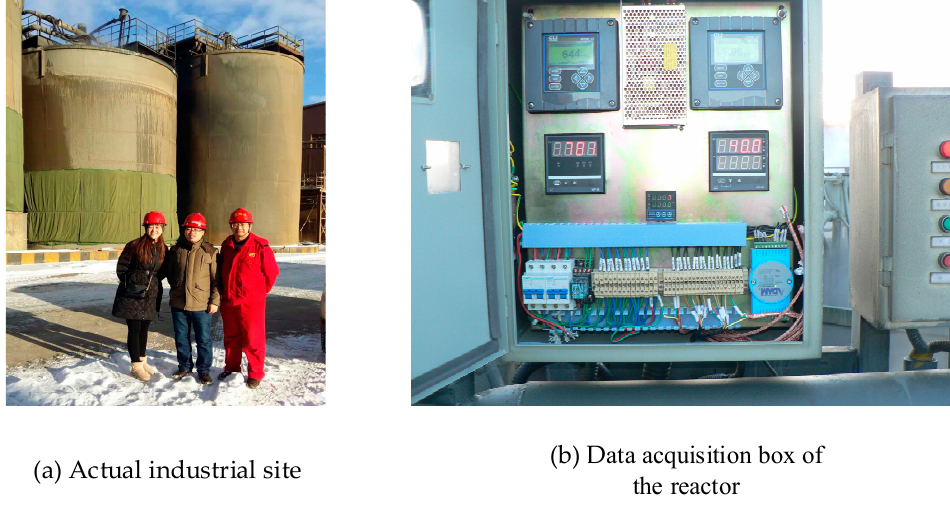
Figure 16. Actual industrial site and data acquisition box of the reactor.